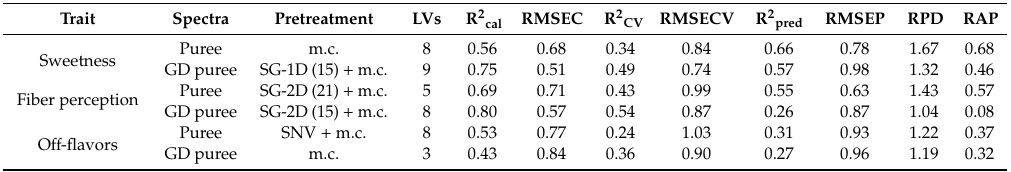
Table2. Statisticaldescriptorsfornear-infraredspectroscopy(NIRS)determinationsusingallthespectra. Trait